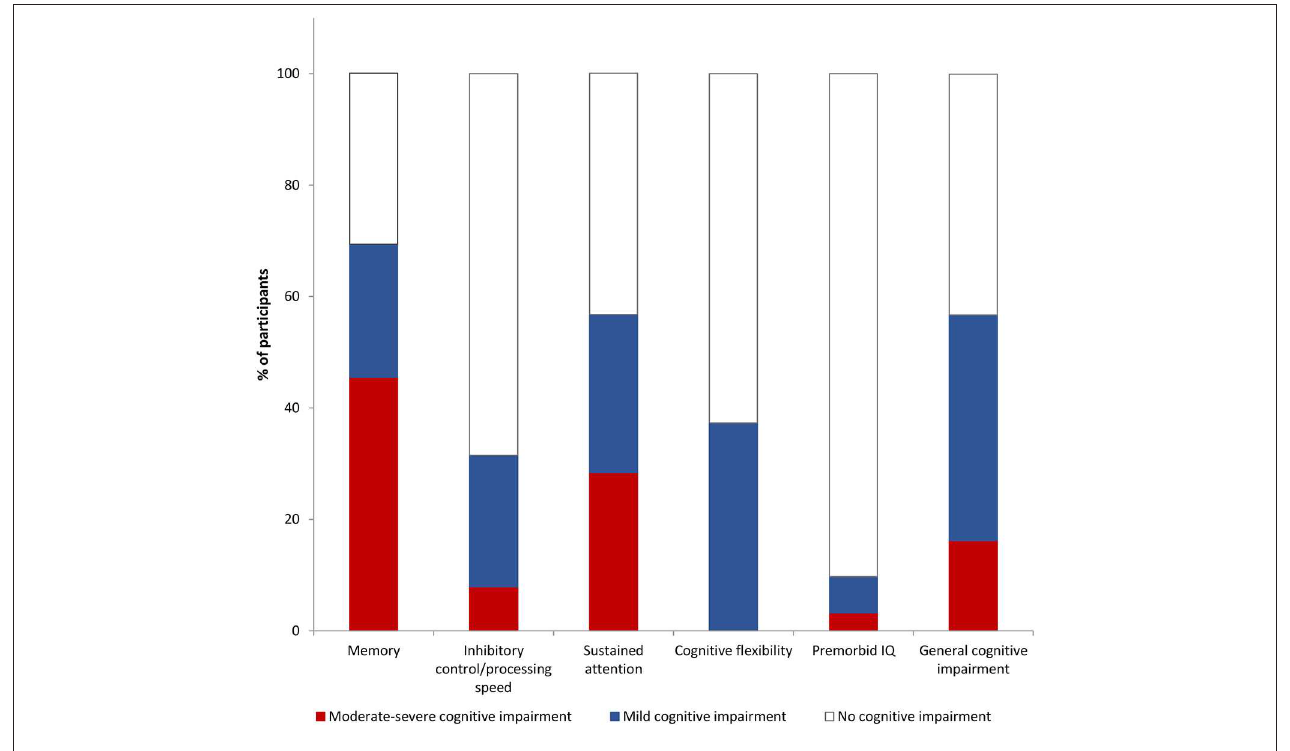
FIGURE 1 | Rates of cognitive impairment in marginally housed youth.